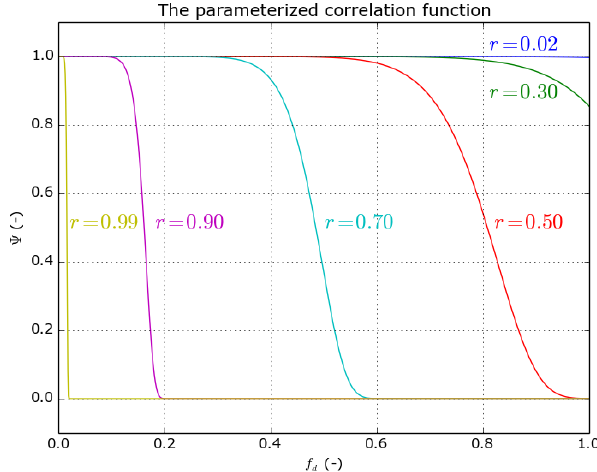
Figure A5. (cid:57)(f d (x 1 ,x 2 )) as in Eq. (A7) for various r . The correla- tion r is a parameter in (cid:57) which varies from 0 to 1. Here (cid:57) is shown as function of f d for several r values, as indicated by the labels in the